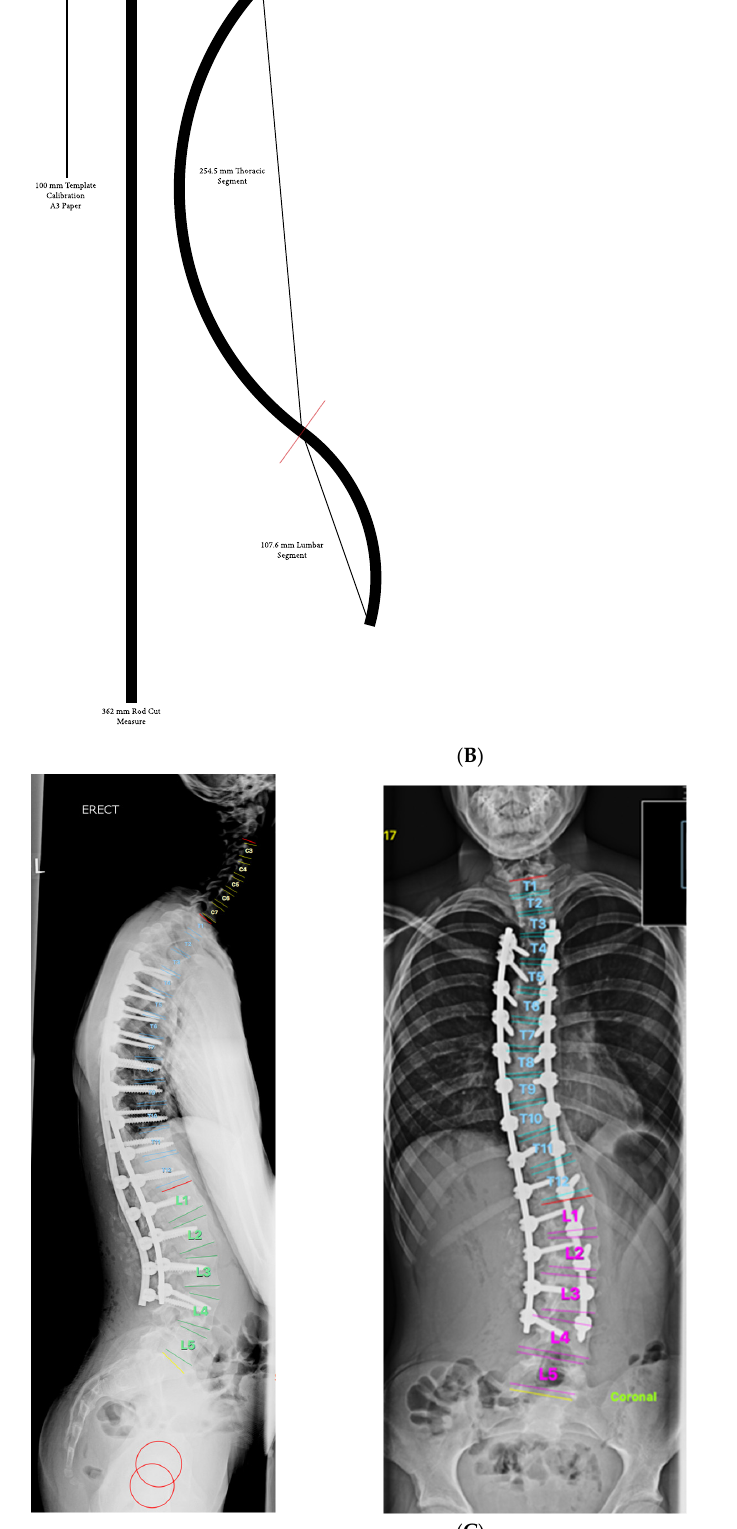
Figure 7. ( A ) Pre-Op MT C obb:65, TL-L Cobb: 78.5, TK: 54 (hyperkyphosis). Predicted TK 45. ( B ) Patient-specific template. ( C ) Post-Op Mt Cobb: 27, TL-l Cobb: 31